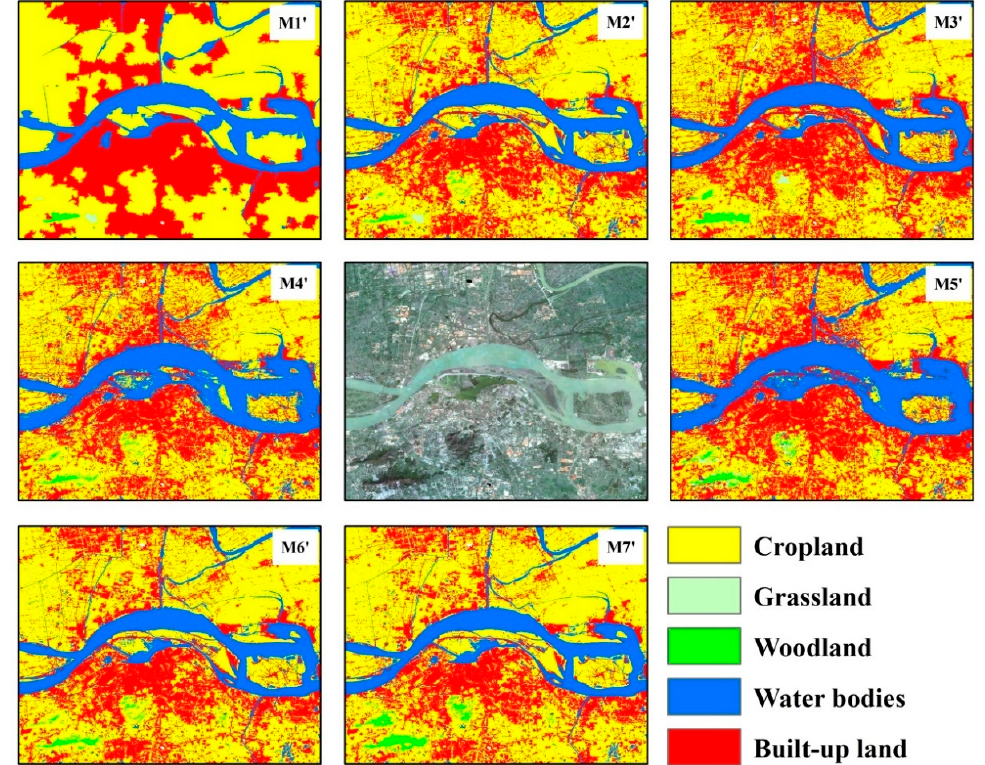
Figure 7. Comparison of the object-based classification results in a typical region. M1’–M7’ indicate the classification results of the seven object-based models listed in Table 3, respectively. The central subfigure is Landsat 8 OLI true color image.